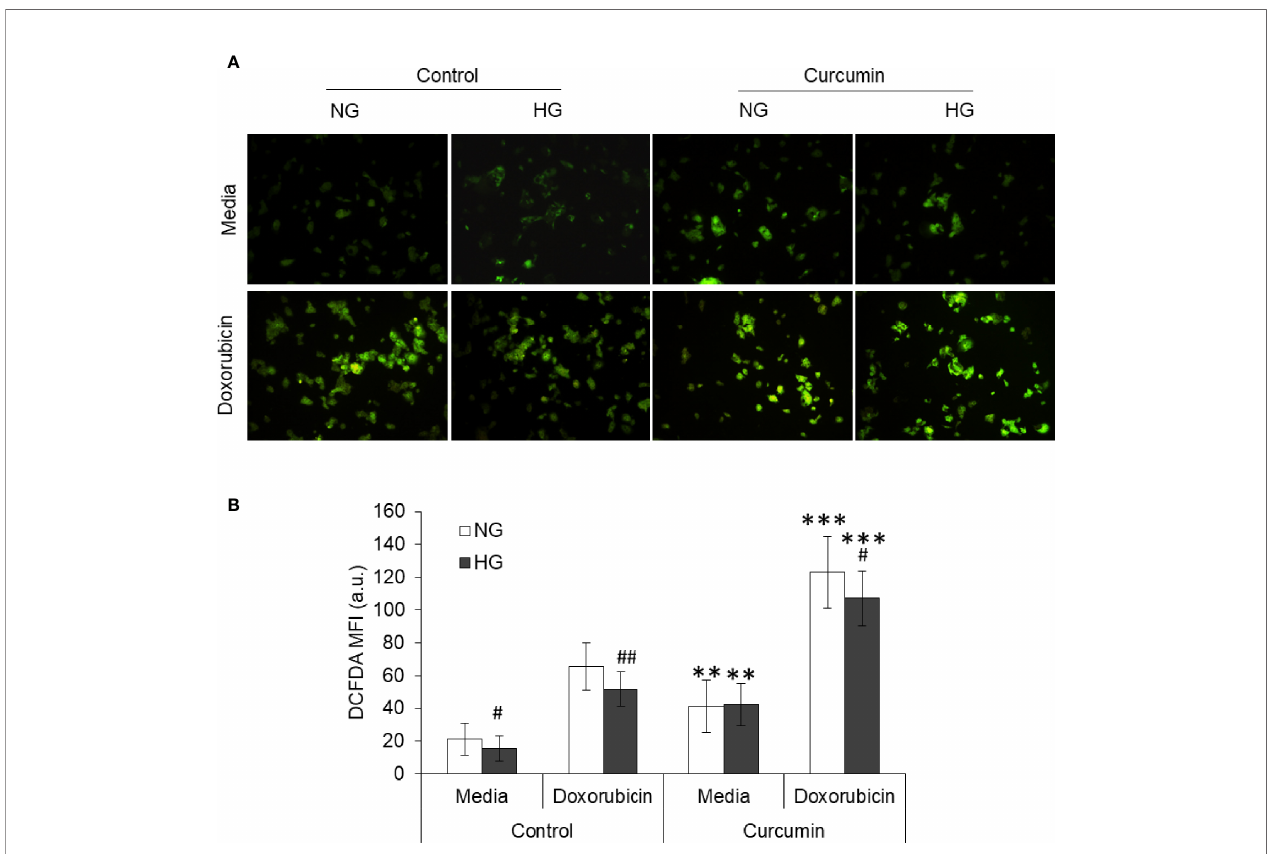
FIGURE 7 | Curcumin favors the ROS production in HepG2 cells in normal as well as hyperglycemic conditions. Using DCFDA fl uorescence, ROS production was detected in cancer cells treated with curcumin, or doxorubicin, or their combinations in NG or HG medium for 24 h. Photomicrograph of DCFDA stained cells were captured (A) . Mean fl uorescence intensity (MFI) of cells was determined using ImageJ software (B) . Photomicrographs shown are representative of three experiments conducted independently. The values shown are Mean ± SD of three independent experiments conducted in triplicate. ** p < 0.01, *** p < 0.001 vs values of cells of control group not treated with curcumin. # p < 0.05, ## p < 0.01 vs values of cells incubated in NG